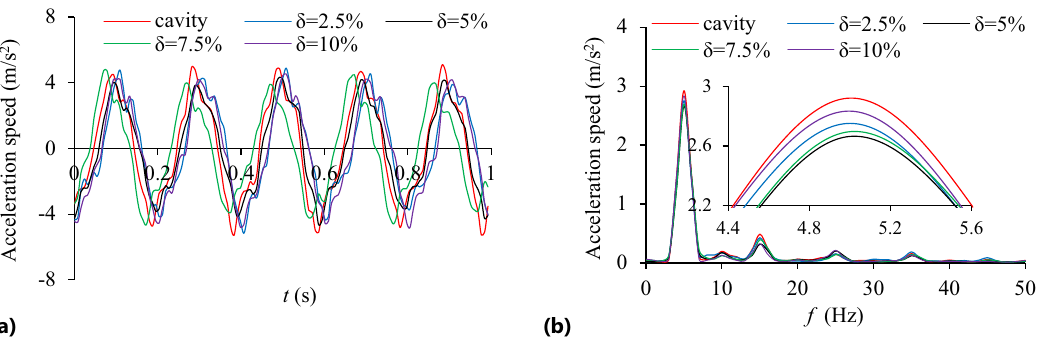
Figure 11. Acceleration speed of system n = 90 r/min: (a) Time-domain; (b) Frequency domain.